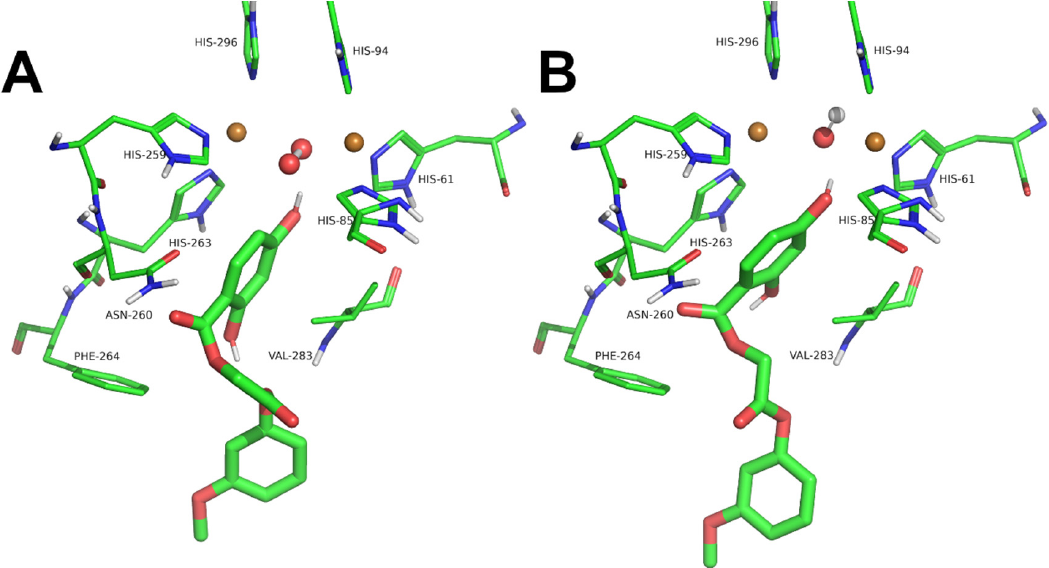
Figure 5. Docking of [2-(3-methoxyphenoxy)-2-oxoethyl] 2,4-dihydroxybenzoate to oxy-tyrosinase ( A ) and met-tyrosinase ( B ). Colour scheme is as in Figure 3.